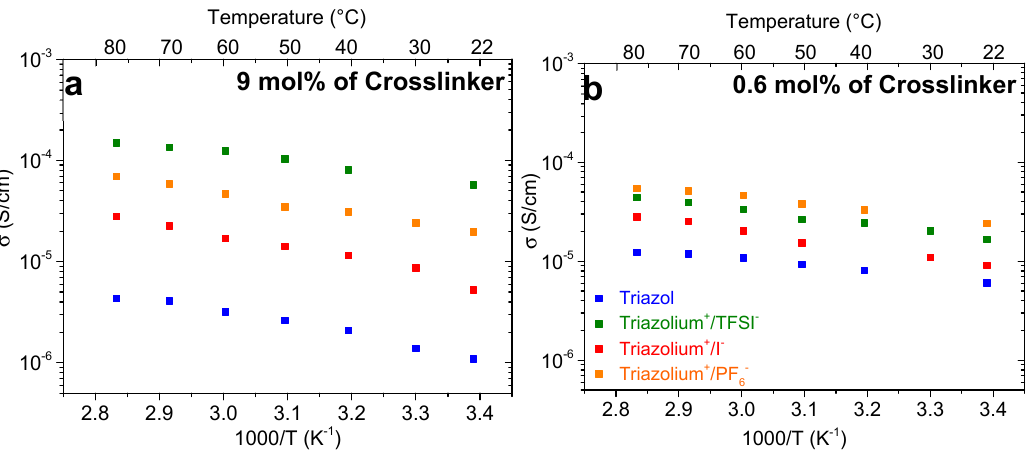
Figure 8. Temperature dependence of the ionic conductivity for PTMA gels comprised of ( a ) 9 mol %, and ( b ) 0.6 mol % of crosslinker.